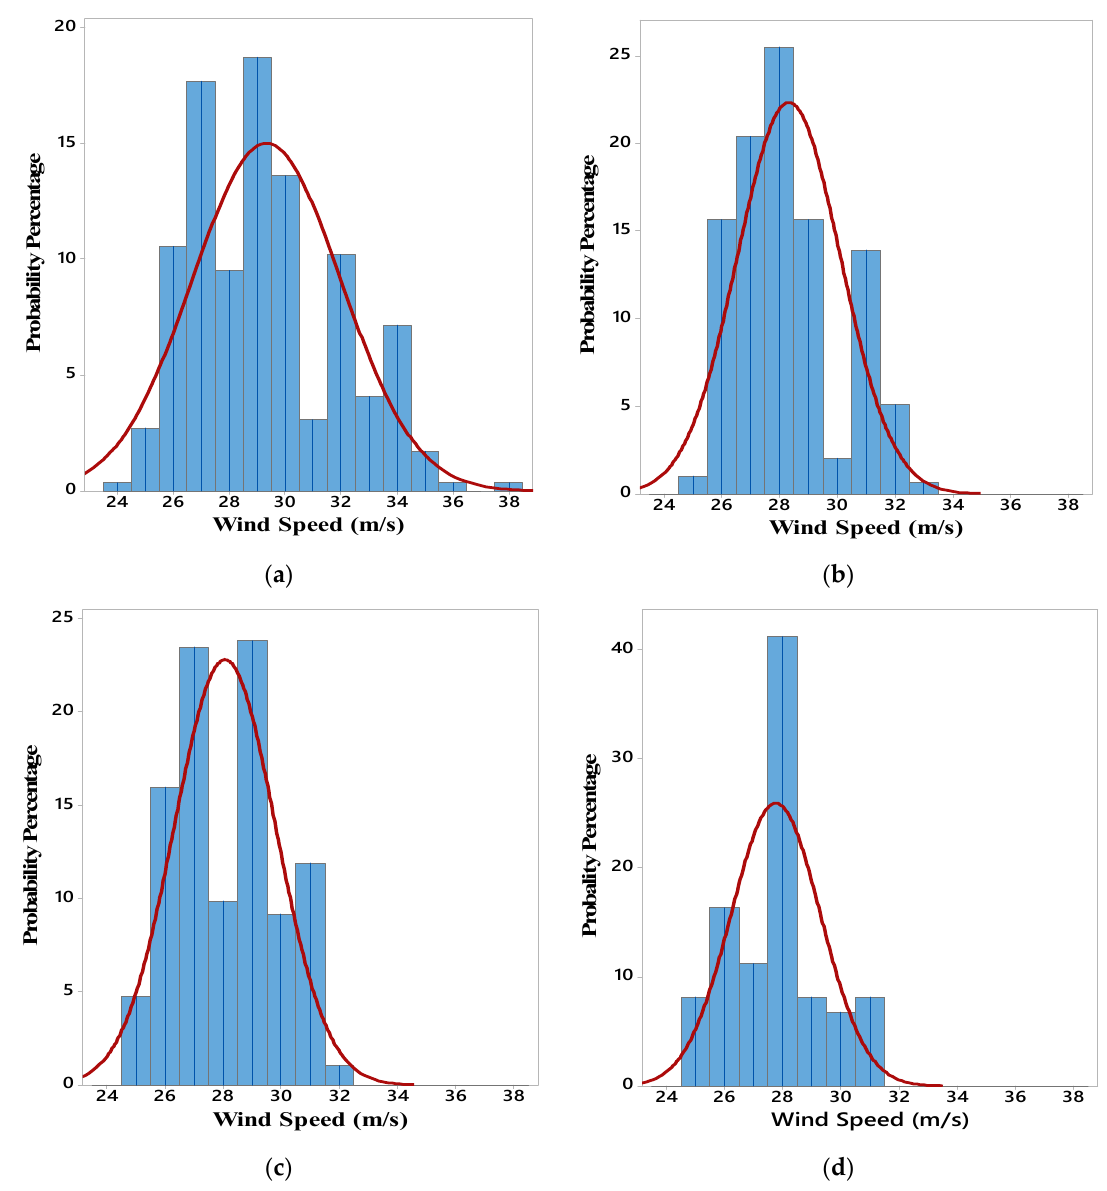
Figure 11. Histogram analysis of wind speed in Peninsular Malaysia: ( a ) V site ; ( b ) V mukim ; ( c ) V s ; ( d ) V District .